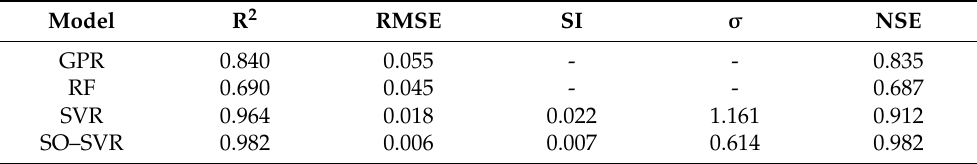
Table 12. Comparison of SO–SVR model with other methods.